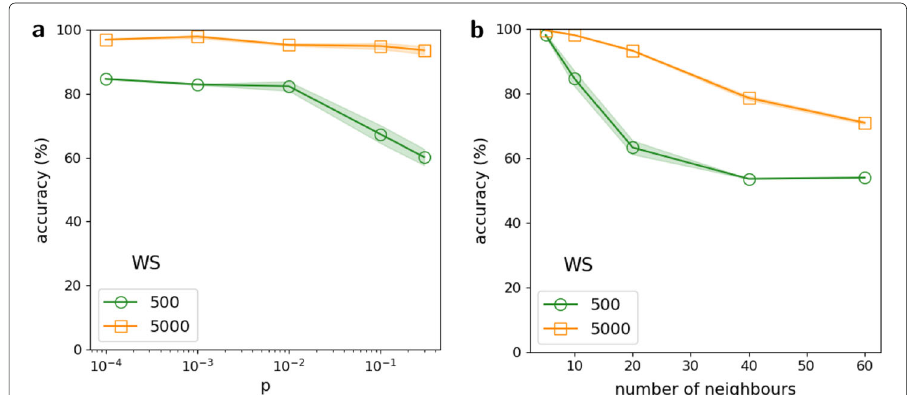
Fig. 5 Accuracy of reconstruction with different parameters in WS network structures. a : WS networks under different re-connection possibility p (while neighbours=20); b : WS networks under different number of neighbours (while p = 0.3); We experimented with two different data sizes: 500 and 5000 pairs of state transition sequences, represented in each plot by green and orange line,